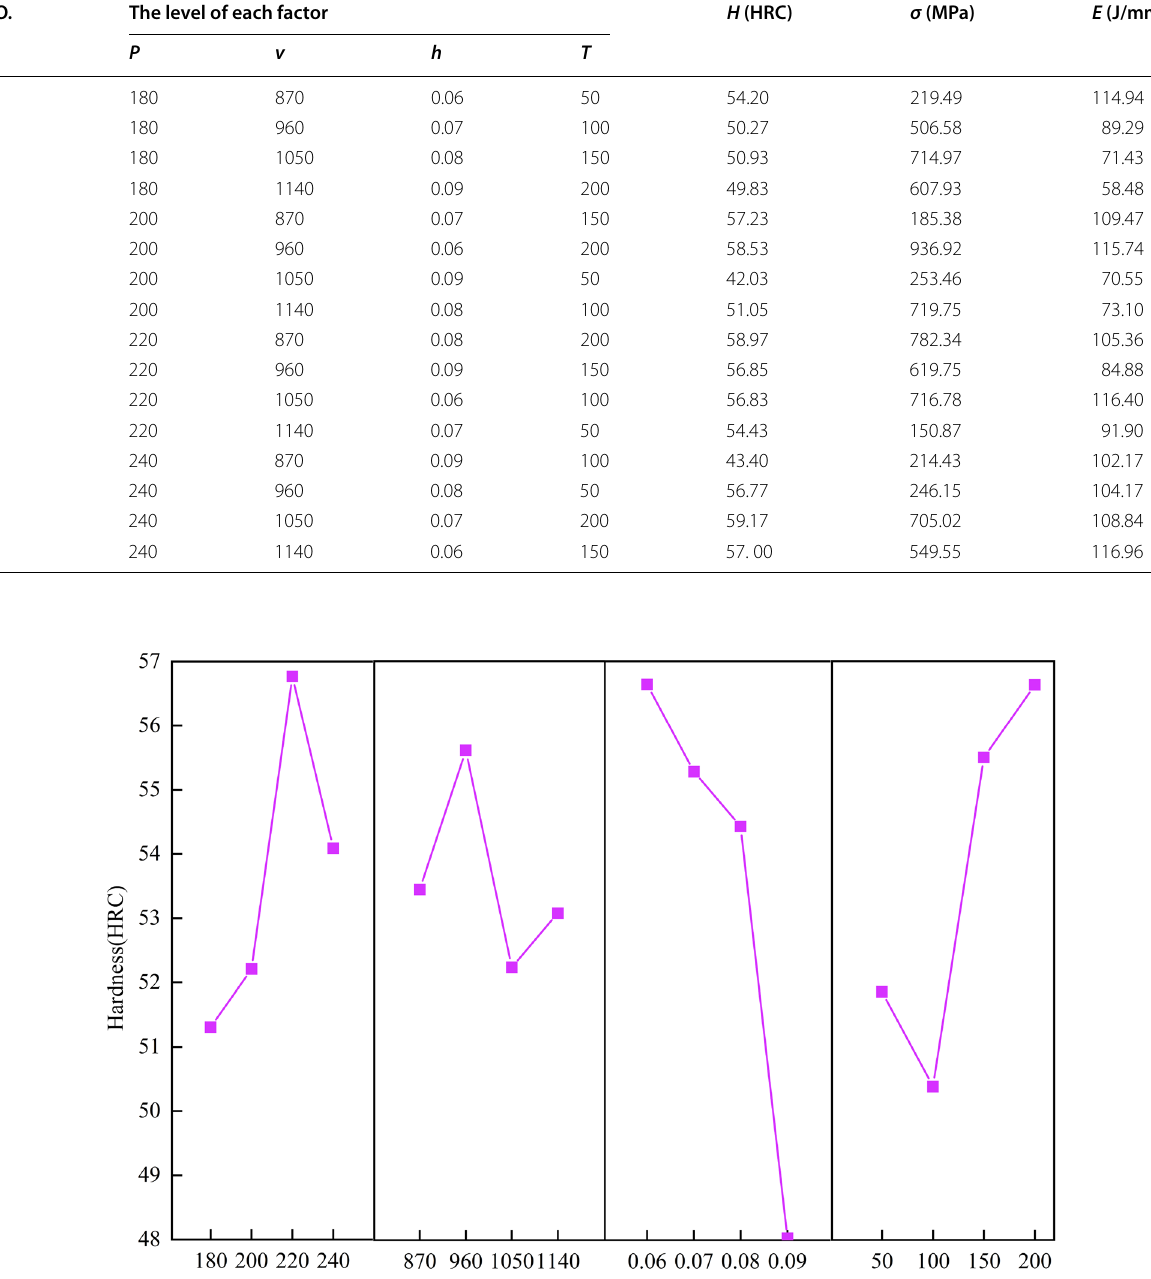
a relatively high level when the scan distance was in the range of 0.06–0.08 mm. The effect of scanning distance on hardness can be attributed to the fact that the sample cannot be densified due to a too large scanning distance.